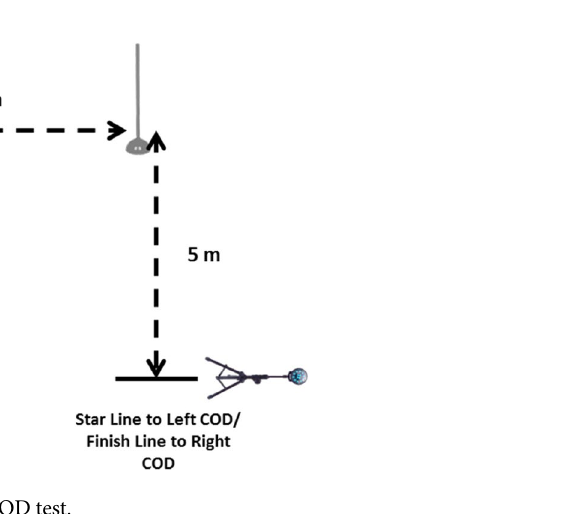
Figure 4. Set up for the 90° COD